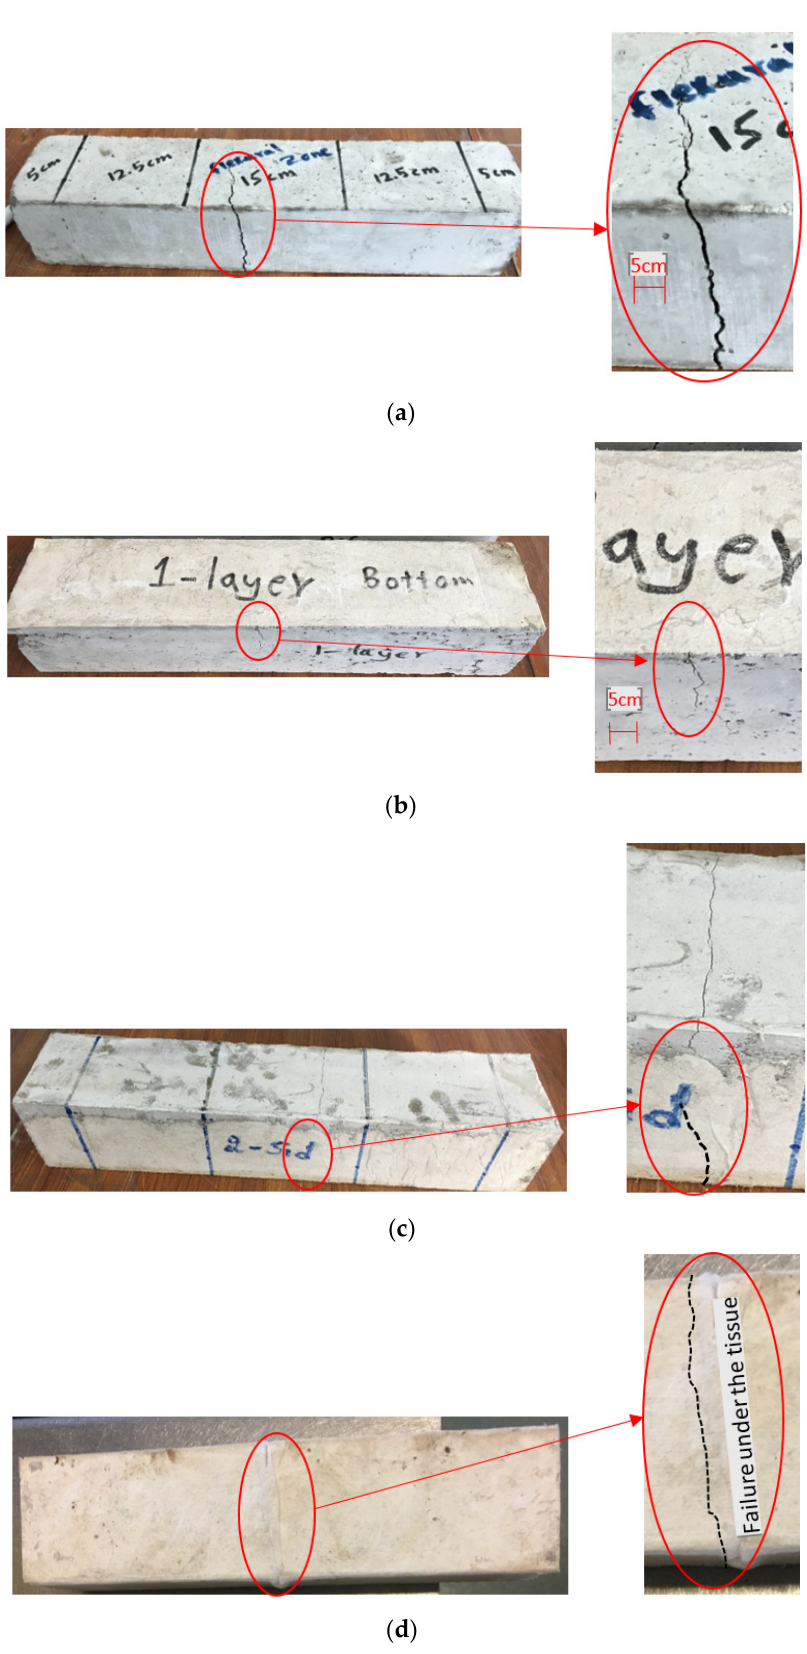
Figure 8. Cracking pattern of beams. ( a ) Reference, ( b ) 1 ‐ layer, ( c ) 2 ‐ sides, and ( d ) 3 ‐ sides.